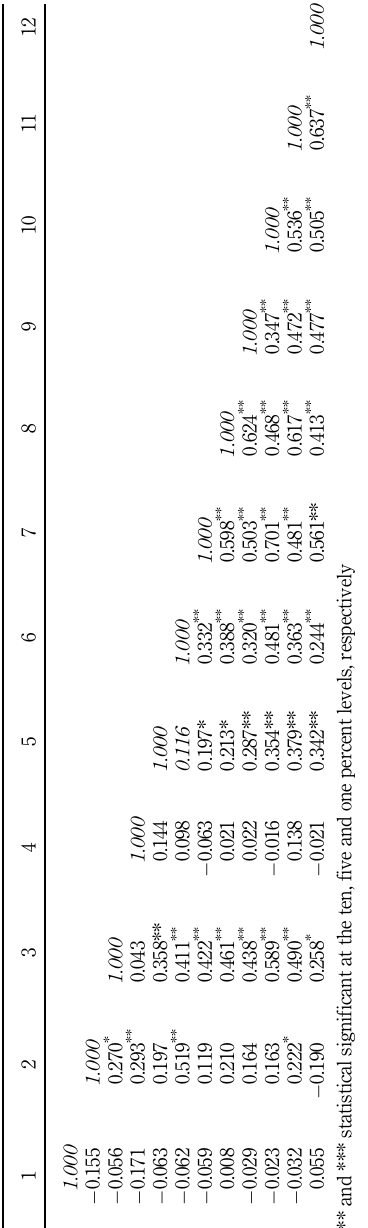
Table 6. Correlation